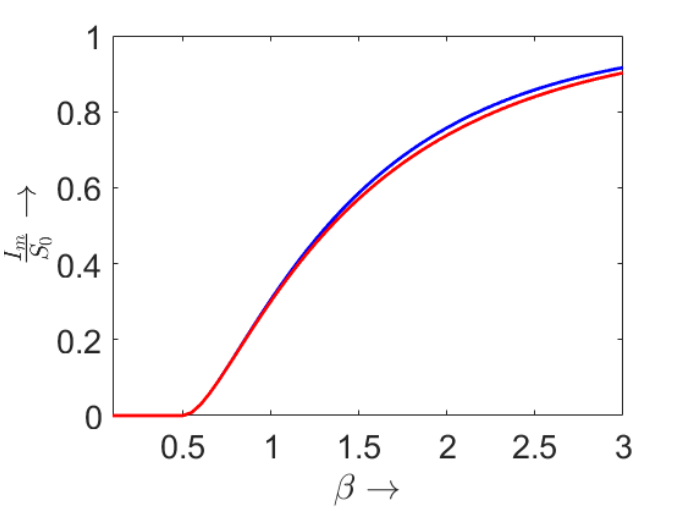
Figure 3. The red curve and the blue curve show the maximum number of infected using the direct numerical simulation of the delay model and using Equations (21) and (23) respectively. Parameter values: N = 10 5 , τ = 4, S 0 = N − 1, I 0 =